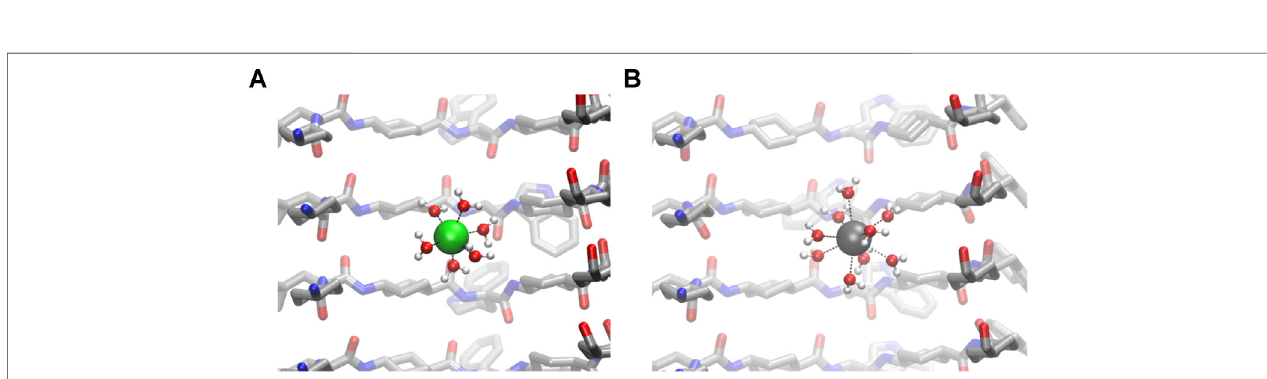
FIGURE6| RDFsforNa + (A) andCa 2+ (B) consideringdifferentcontributions(water,COgroups,andCl − ions),normalizedbythenumberofcationsandnumberof contributions. Just the last 180 ns were considered for the analysis. Note that the scales for the three contributions are not the same.